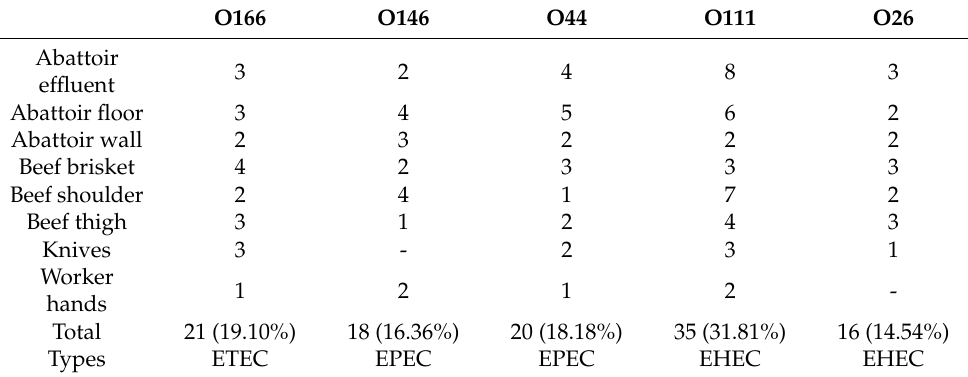
Table 2. Serotyping of E. coli strains isolated from beef carcasses and slaughterhouse environments samples. O166 O146